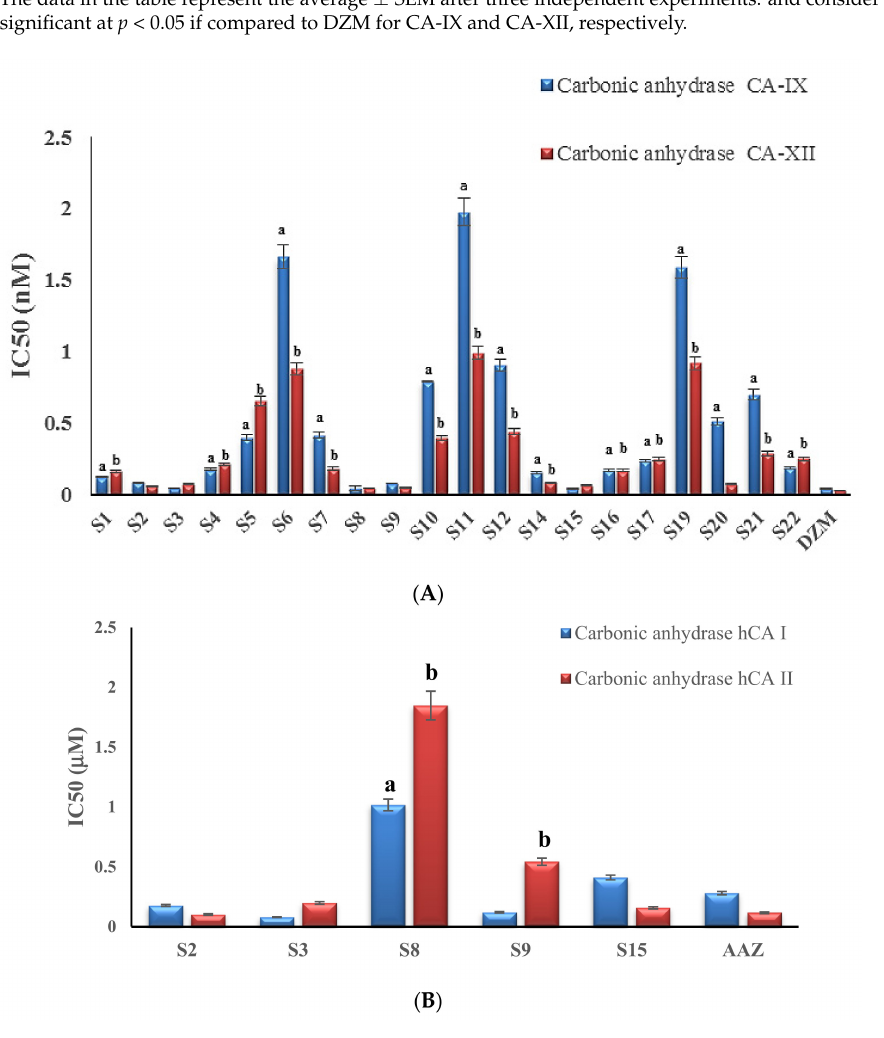
Figure 3. ( A ) Human CAIX, XII inhibitory effect of S1 – S22 compounds using Dorzolamide HCL as reference standard. a and b consider statistically significant at p < 0.05 if compared to DZM for CA-IX and CA-XII, respectively. ( B ) Human CAI, II inhibitory effect of S2 , S2 , S8 , S9 and S15 compounds. Data represent mean ± SEM after three independent experiments. a and b consider statistically significant at p < 0.05 if compared to AAZ for hCAI and hCAII,